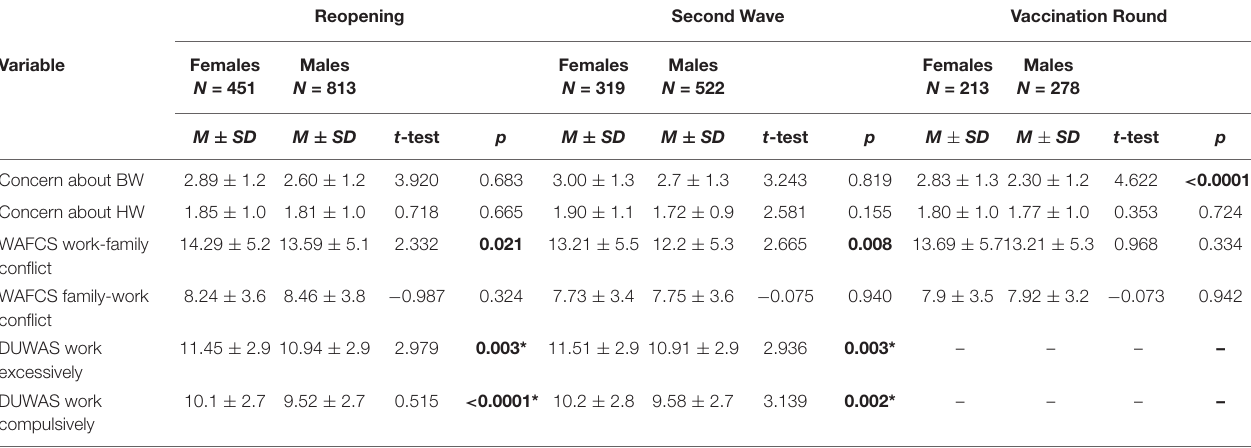
TABLE 4 | Questionnaires scores in Reopening, Second Wave, and Vaccination Round groups by gender. Reopening